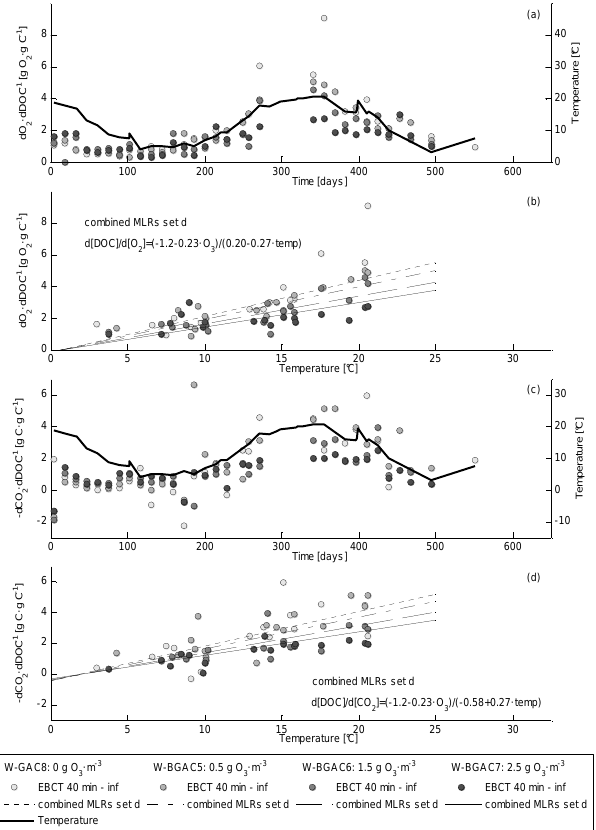
Figure 5. Oxygen consumption to DOC removal ratio (a) , oxygen consumption to DOC removal ratio as function of temperature from day 194 to 559 (b) , carbon dioxide production to DOC removal ratio (c) and carbon dioxide production to DOC removal ratio as function of temperature from day 194 to day 559 (d)